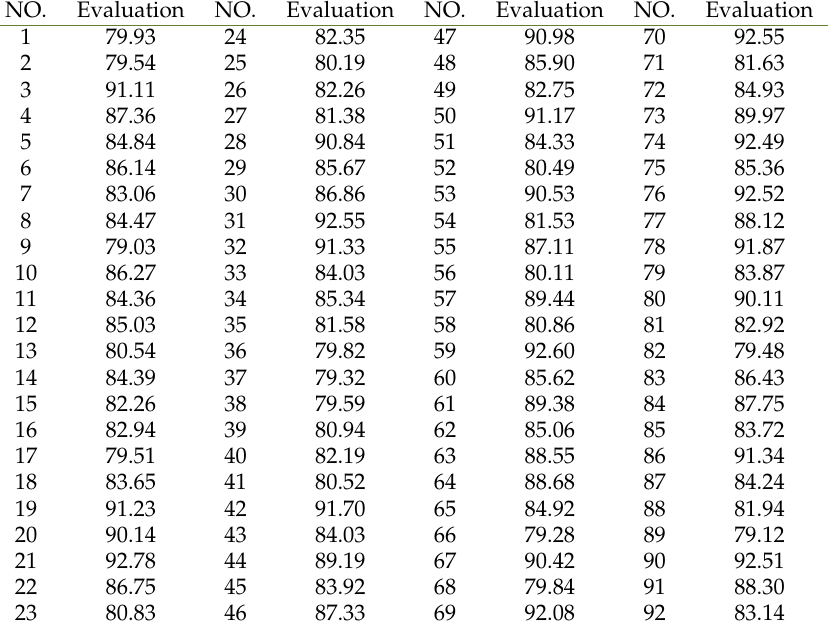
Table 2. Statistical table of evaluation of Guilin tourism innovation ability NO. Evaluation NO. Evaluation NO. Evaluation